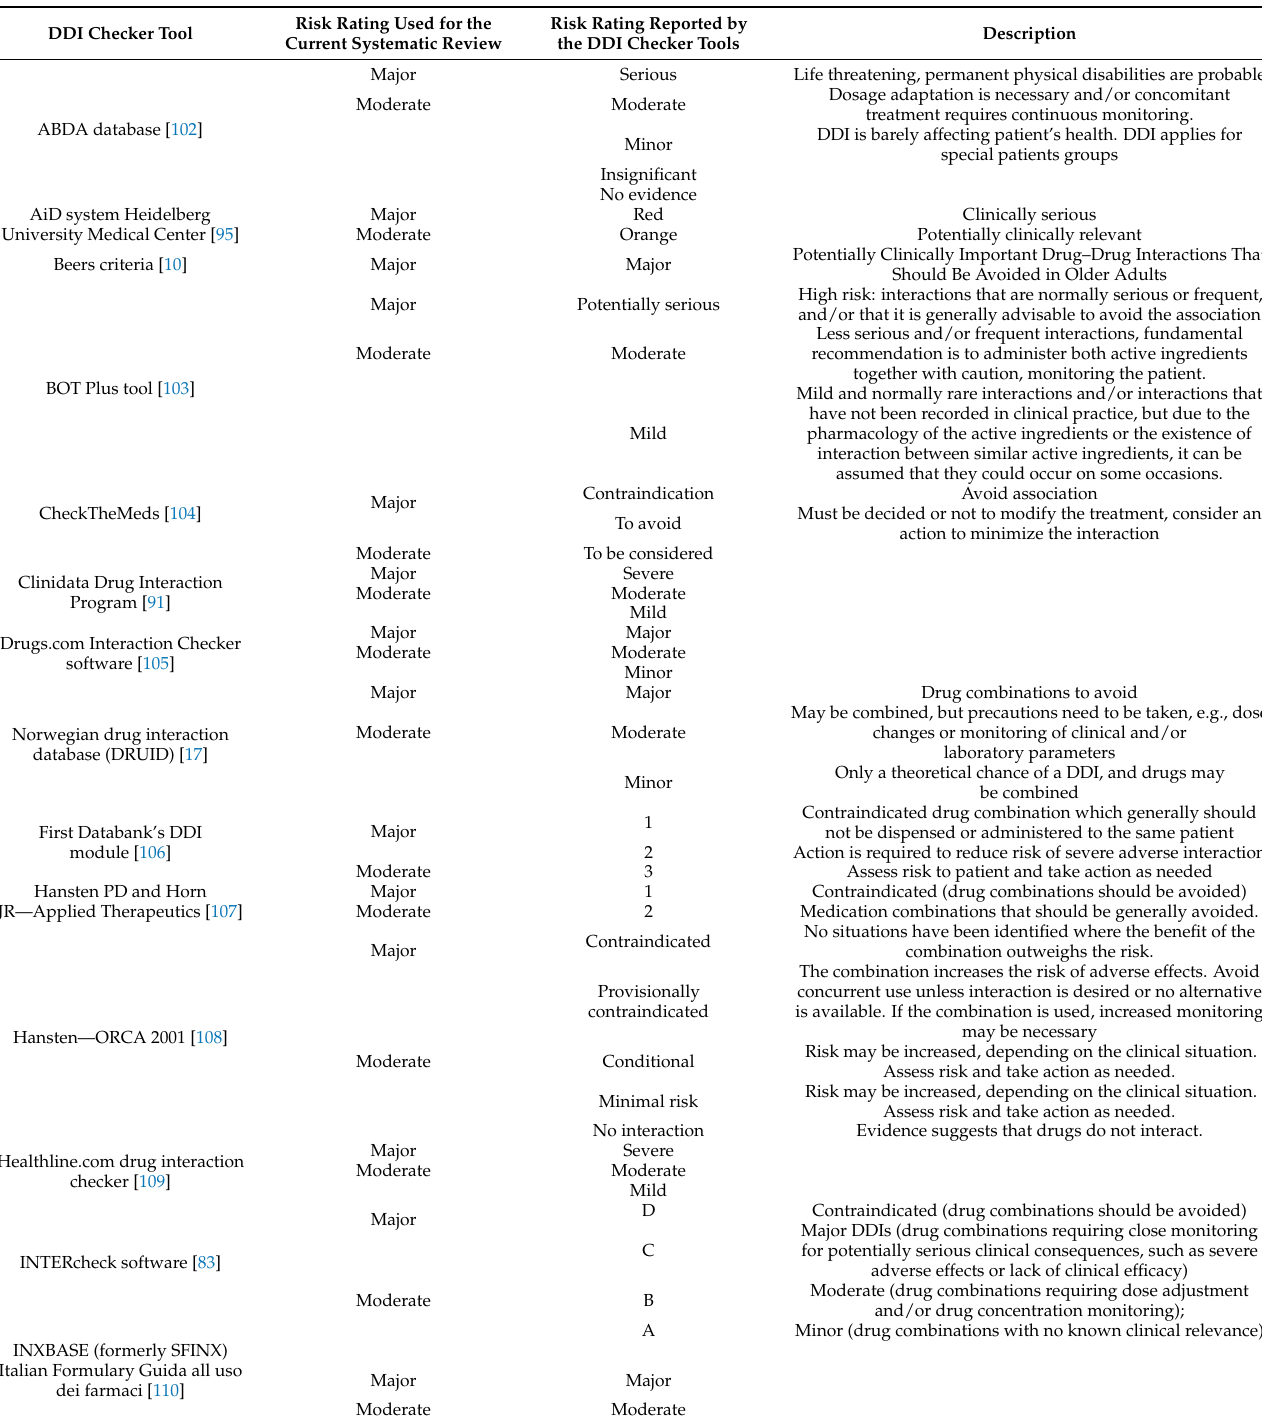
Table 4. Mapping of the potential risk rating classification of DDI among checker tools used in the studies referenced in the current systematic